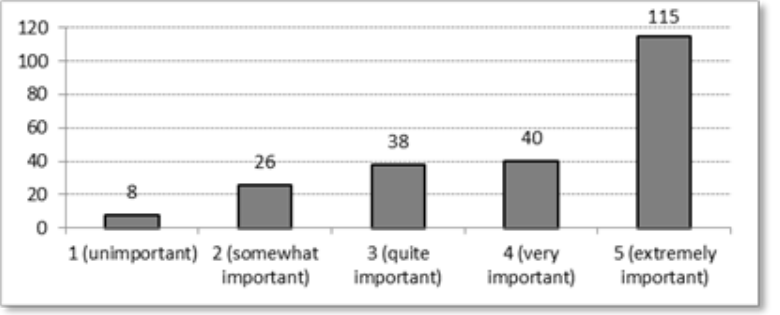
Figure 7. Importance given by deaf and hard of hearing e-learning students to the quality and attitude of instructors (absolute numbers). Valid answers: 227.